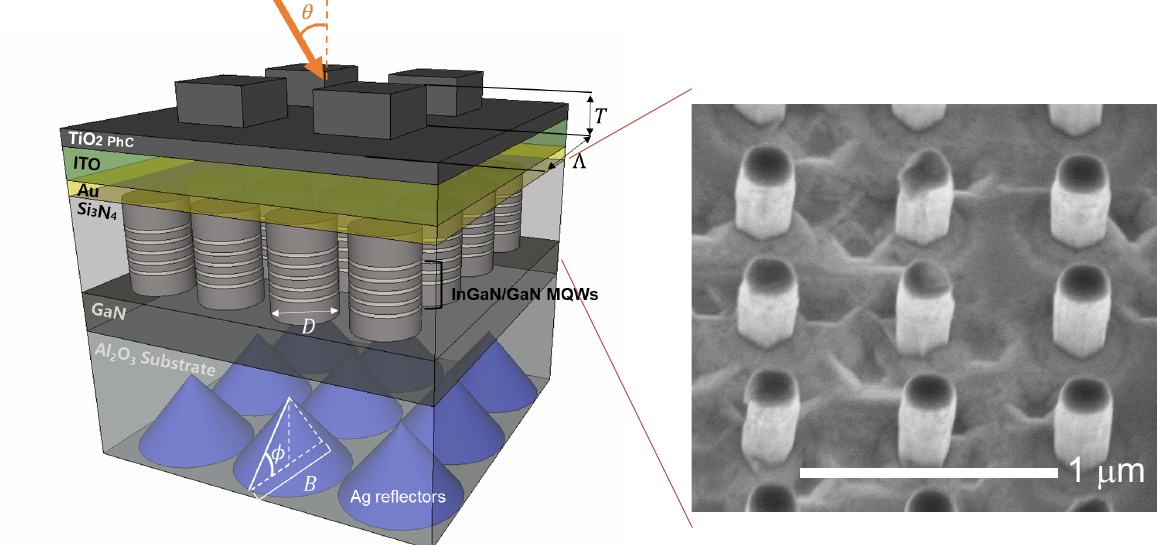
Figure 1. Schematic of the proposed wavelength-selective photodetector. The structure consists of three parts: the light- absorbing InGaN/GaN MQW active region, the photodetector p-type (ITO, Ni/Au) and n-type (not shown) contacts, and the light-trapping structure consisting of the silver (Ag)-coated cone-shaped back-reflector and the top TiO 2 photonic crystal (PhC) layer. An unpolarized light incidents at an angle θ . The InGaN active region and the GaN pn junction are formed by lithographically patterning a thin-film structure of the same epitaxial stack, as shown by the scanning electron micrograph on the right, with an array of InGaN DIW nanopillars with a diameter of 200 nm before filling the space between the nanopillars with the insulating Si 3 N 4